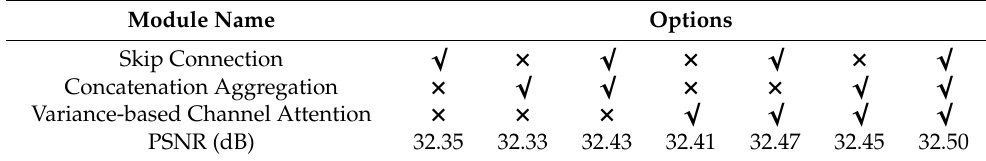
Table 1. Ablation results of di ff erent modules combined with the DRFFN are reported by showing the best PSNR (dB) values on Set5 ( × 4) in 100